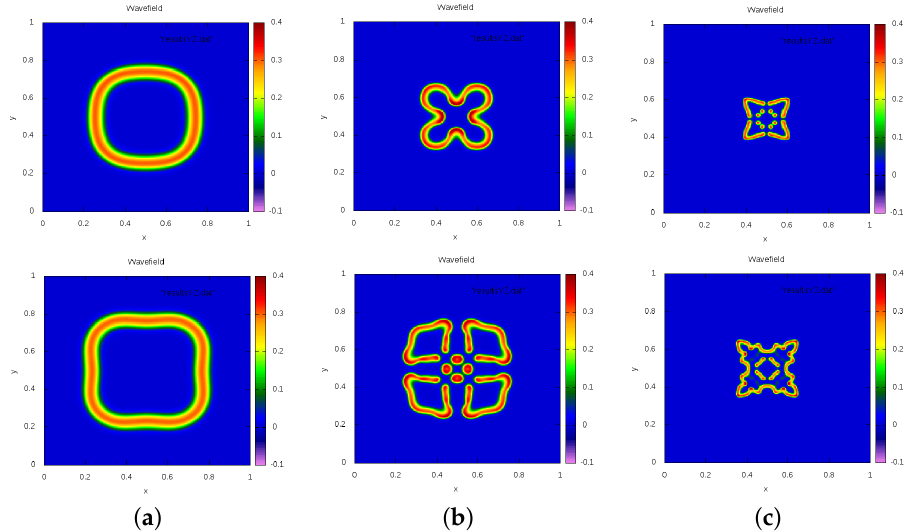
Figure 1. Dynamics of the v wave in the Gray-Scott model at different times t = 2000,3000. The v contours are shown from top to bottom for three fractional orders: ( a ) α = 1, ( b ) α = 0.85, ( c ) α =